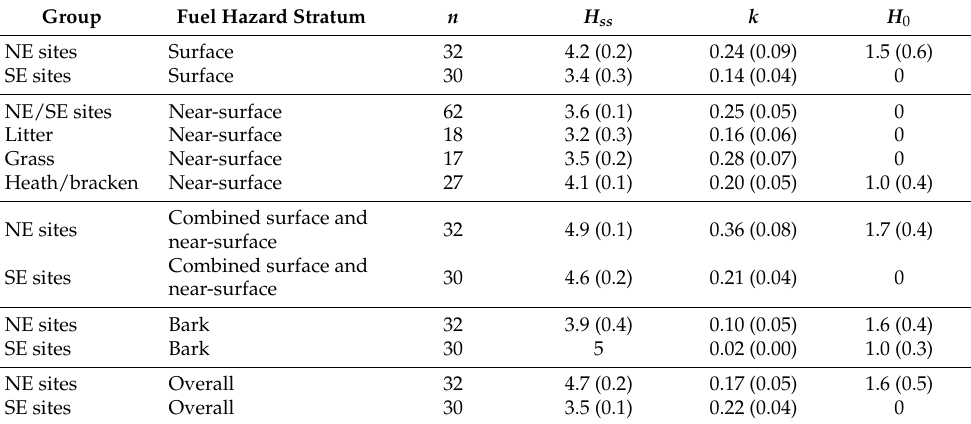
Table 8. Estimated parameters with standard errors (in parentheses) for hazard rating models.